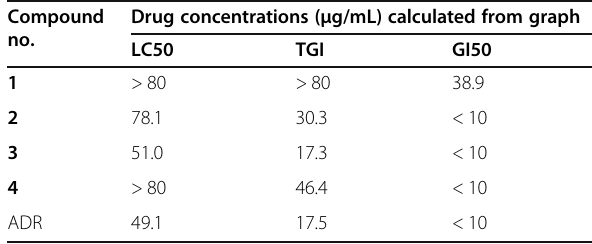
Table 6 Parameters calculated from graph (Fig. 4) BT474 cell line Compound